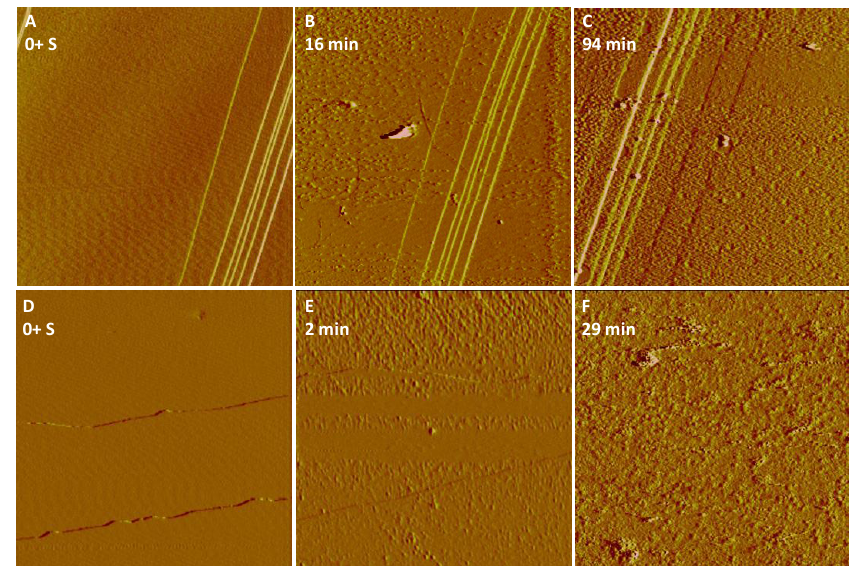
Figure 5. AFM images of fast nucleation of Fe-P particles formed on ( A – C ) hematite or ( D – F ) goethite surfaces after injecting 50 mM NH 4 H 2 PO 4 + 10 mM AlCl 3 (pH 4.5). The scan area was almost fully covered with the nucleating fine nanoparticles following 29-min-reaction, passivating the reacting